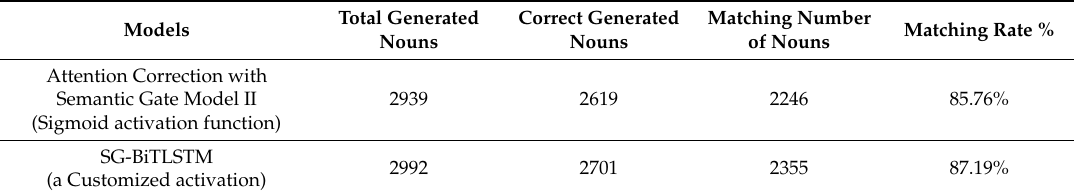
Table 6. Result of the 2 activation functions.